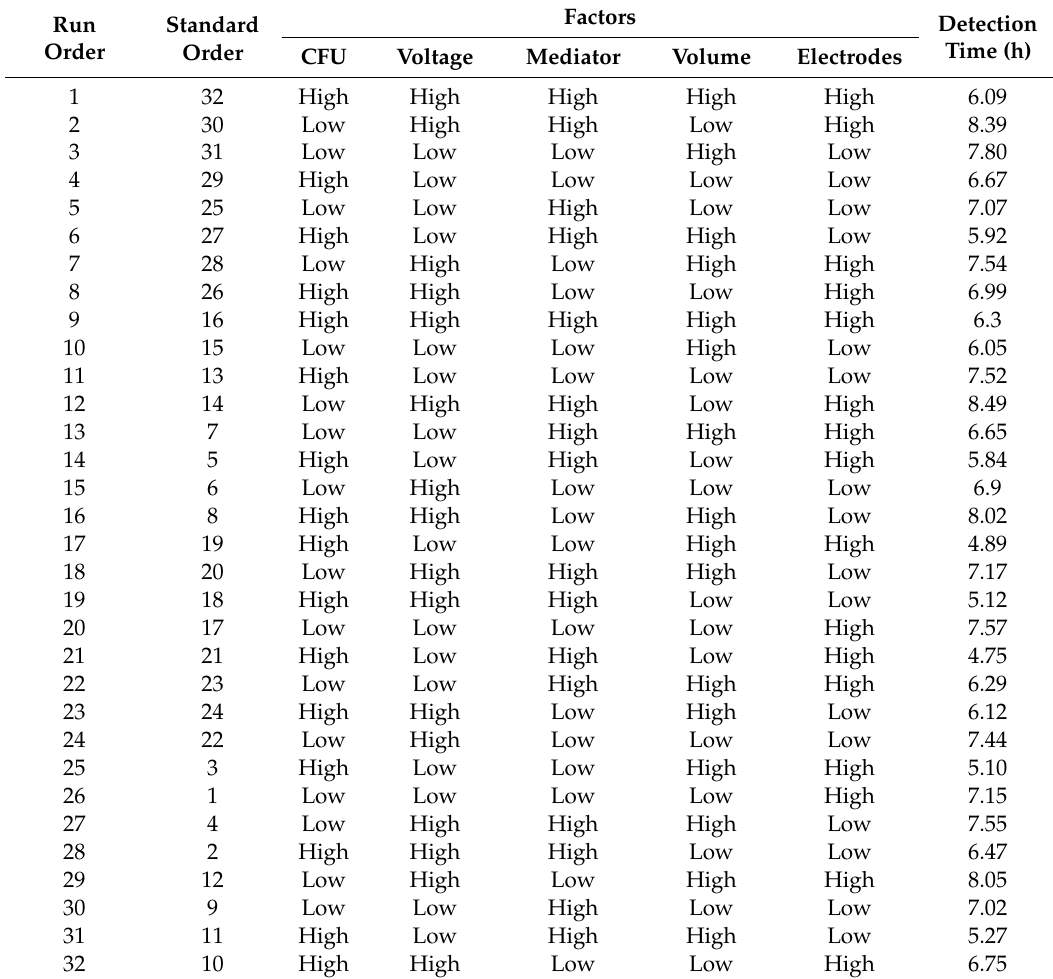
Table 1. Experimental design matrix and raw output data (detection time) generated using the DOE feature in Minitab ® . The following five factors were set either low or high consecutively: Inoculum, 500 and 5000 CFU; voltage, 200 and 600 mV; mediator, HNQ and HNQG; volume, 0.5 and 1.0 mL; electrodes, SPE and CNT. The experiments were ran in random blocks of